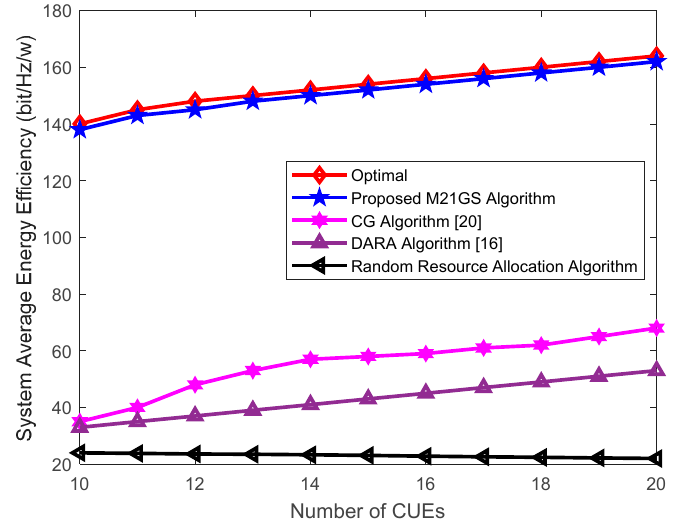
Figure 8. Average Energy Efficiency comparison under different number of CUEs.